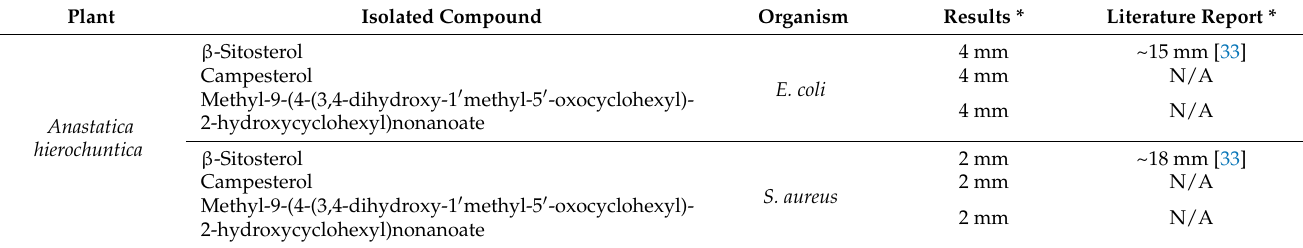
Table 5. Antibacterial activity of metabolites identified in extracts of Anastatica hierochuntica and Aerva javanica